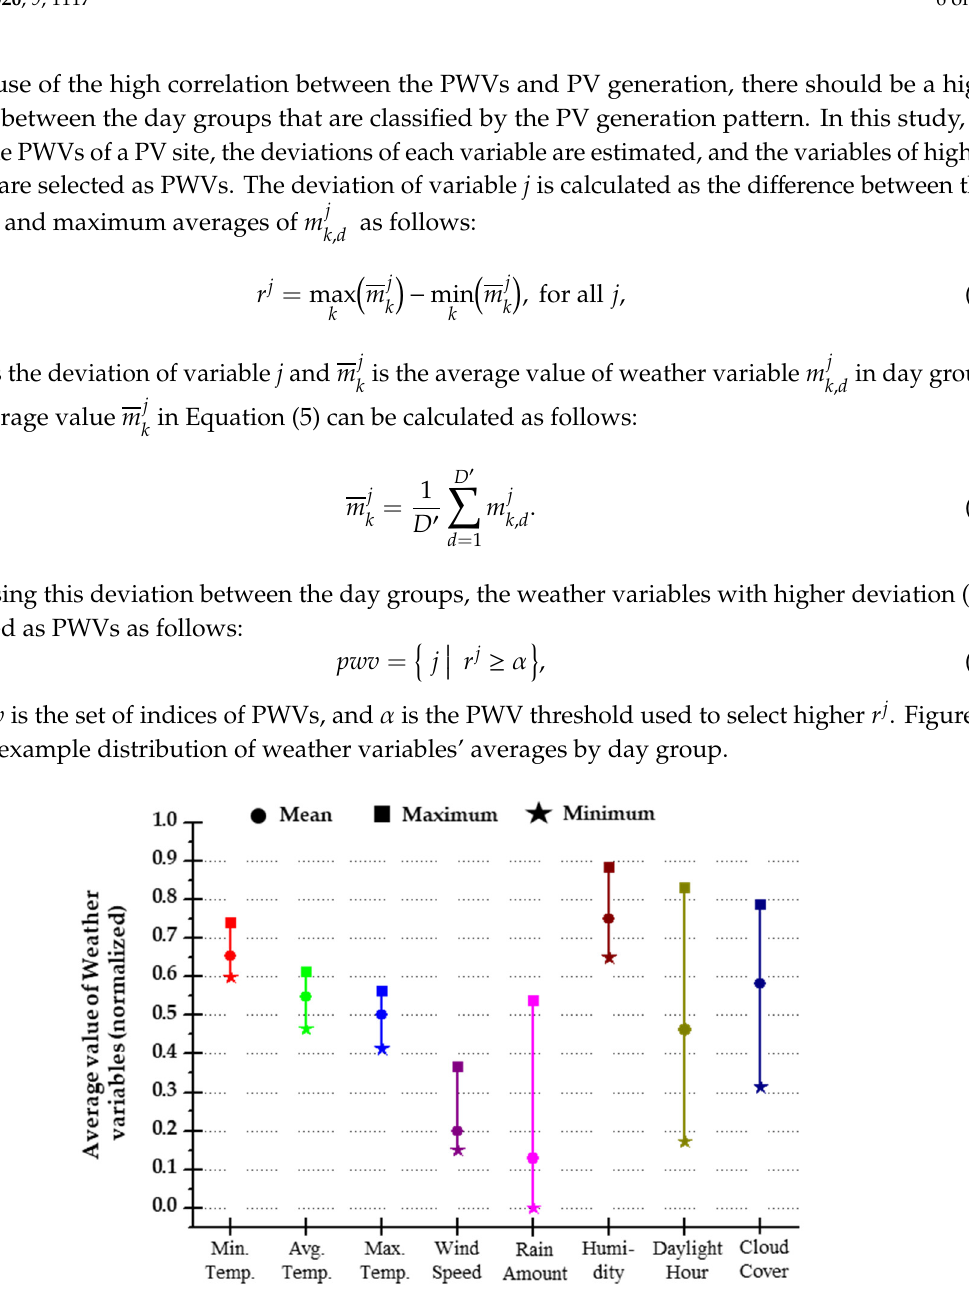
Figure 4. Example distribution of weather variables averaged by day group.